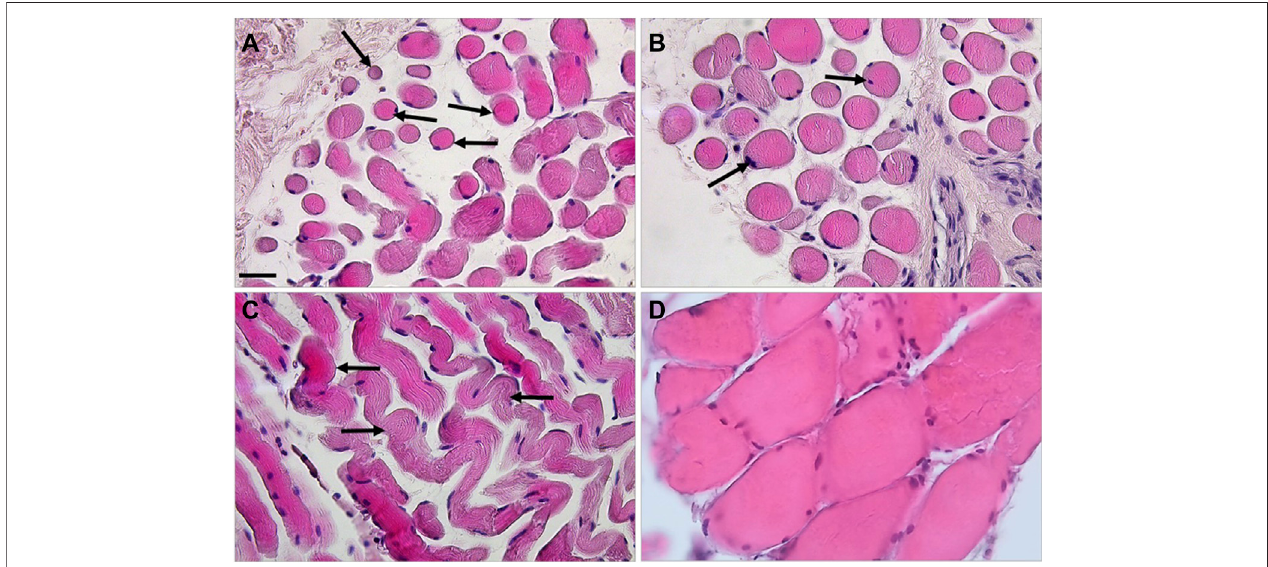
FIGURE1| Haematoxylin-eosinstainingrevealedstrikingdifferencesbetweentheMUT(panels A – C )andCTR(panel D )muscles.Incross-sectiontheMUTmuscle fi bers appeared rounded, of diverse sizes, with swelled nuclei in contact with the sarcolemma or near it (examples shown by arrows on panels A,B ). These fi bers in longitudinal section showed a wavy shape with a striated pattern inside (examples shown by arrows on panel C ). The inter- fi ber space is considerably wider in the MUT than in the CTR muscle. Bar = 100 µm.